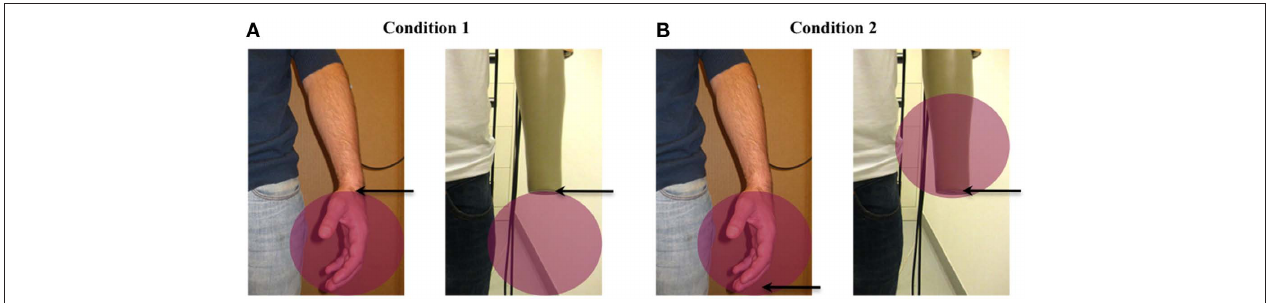
mannequin’s stump , so as to make the participant’s fingertips coincide with the end of the mannequin’s stump. The red circles indicate the area on which simultaneous strokes were applied, and the arrows indicate the point of the arm of the participant that was touched at the same time as the end of the